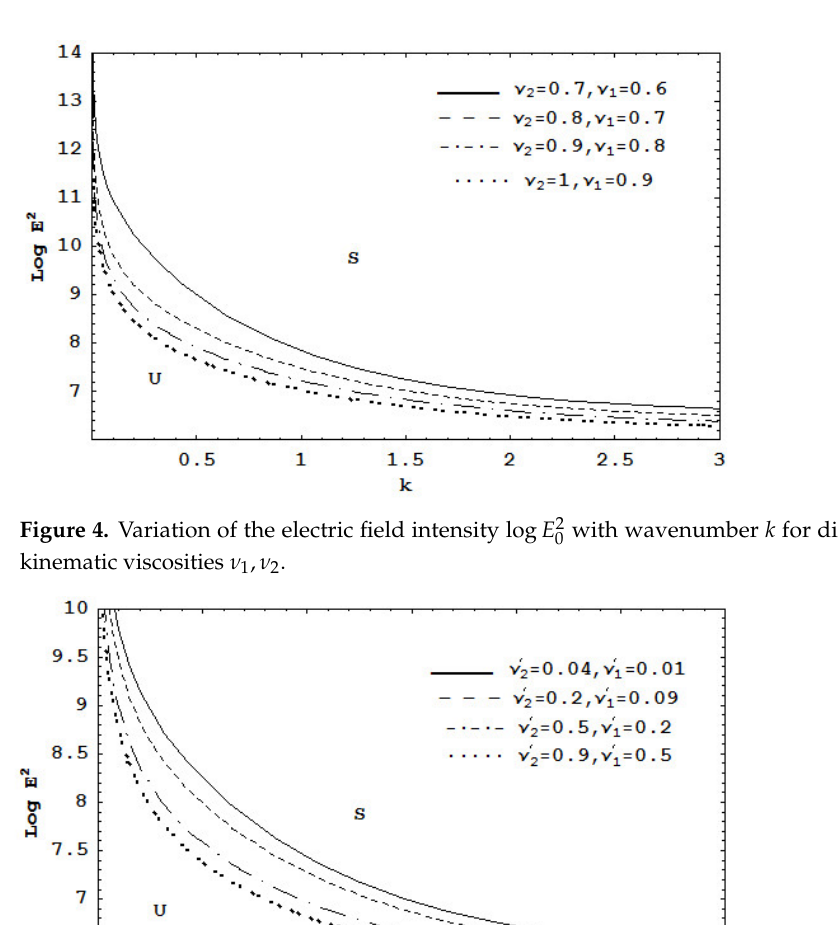
with wavenumber k for different values of 0